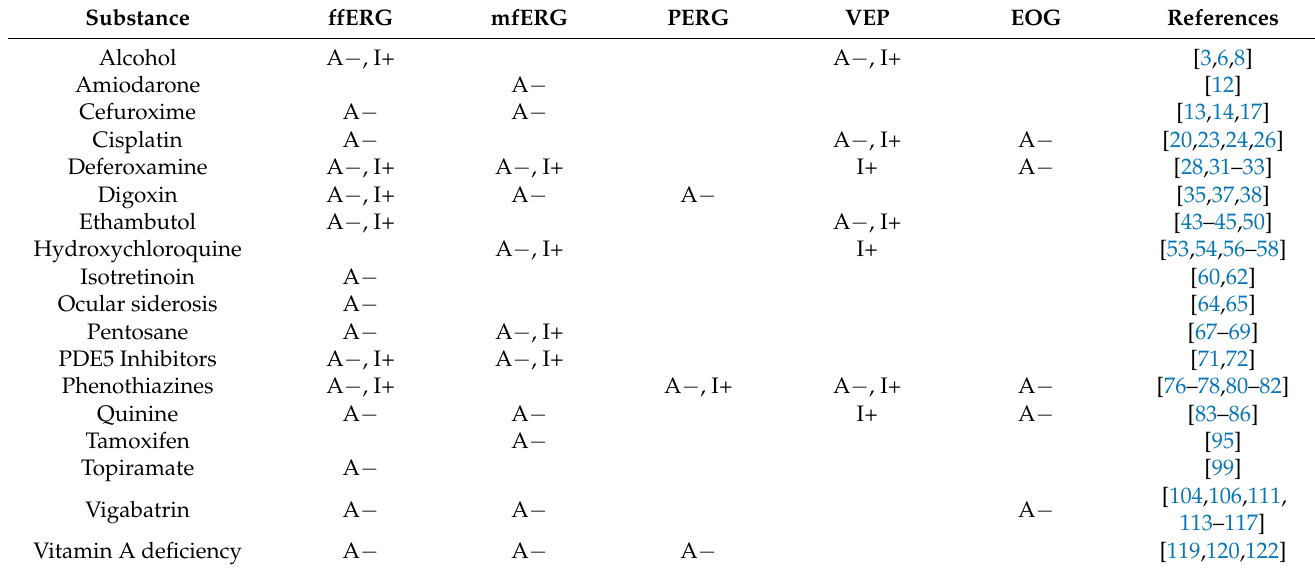
Table 2. Parameters of visual electrophysiologic responses that are affected by different substances